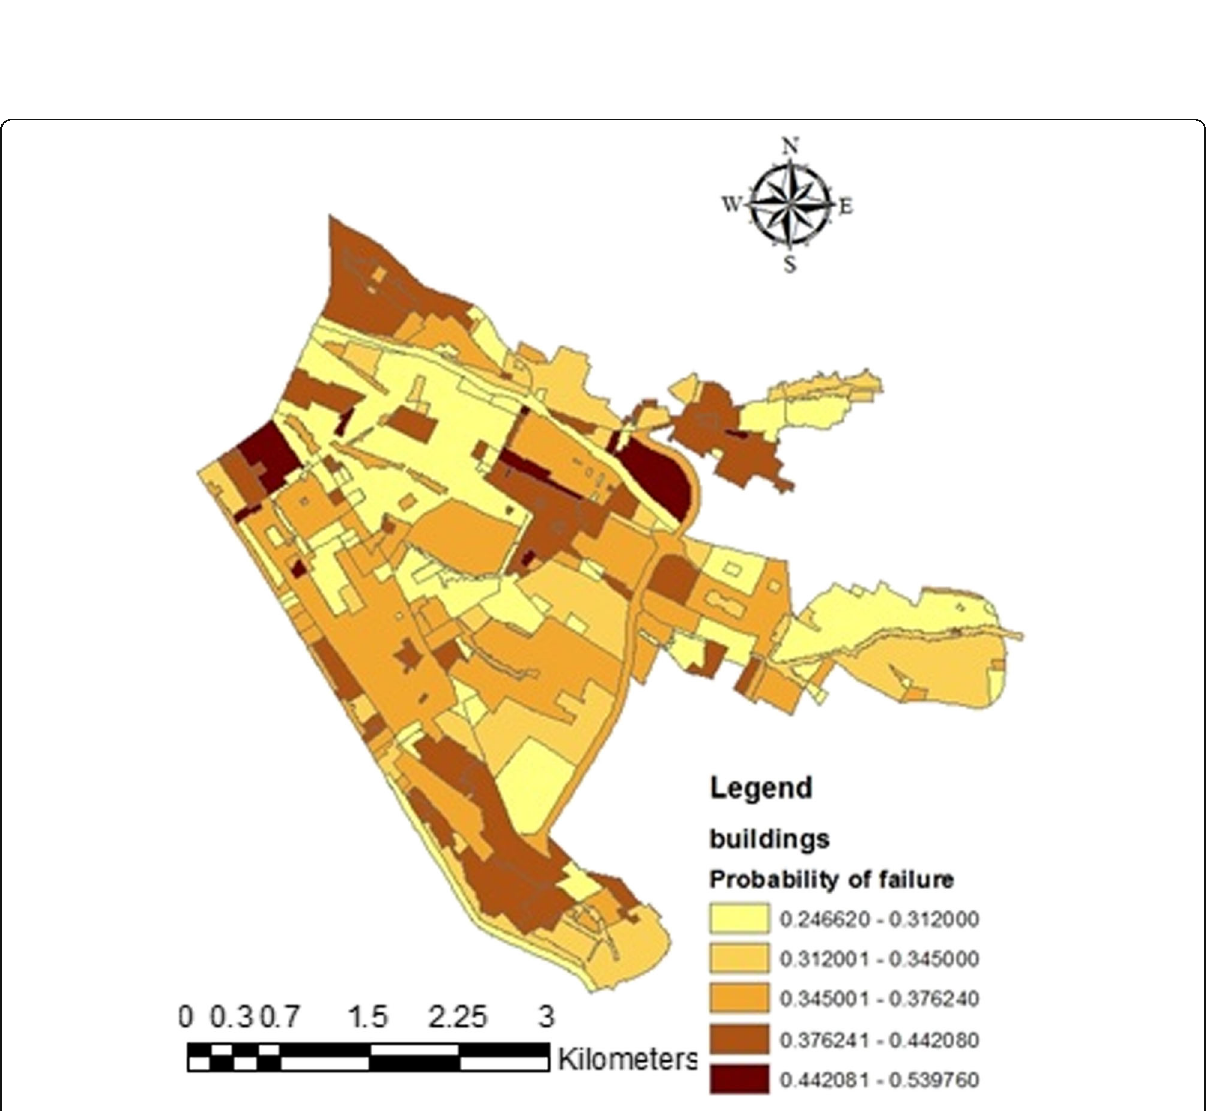
Fig. 9 Building damage due to the earthquake (moderate